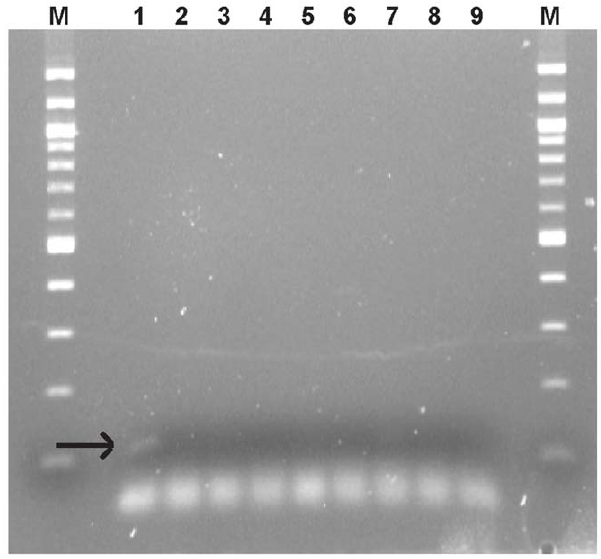
Figure 2. Amplification of the arp gene fragment from the extracts obtained at the UAC¸. M, molecular weight marker, 100 bp DNA ladder (Sigma); 1, ELS 551; 4,7, ELS 558; 2,5 unaffected ancient samples; 3,6,8 extraction blanks (KE); 9, PCR blank (K 2 ).